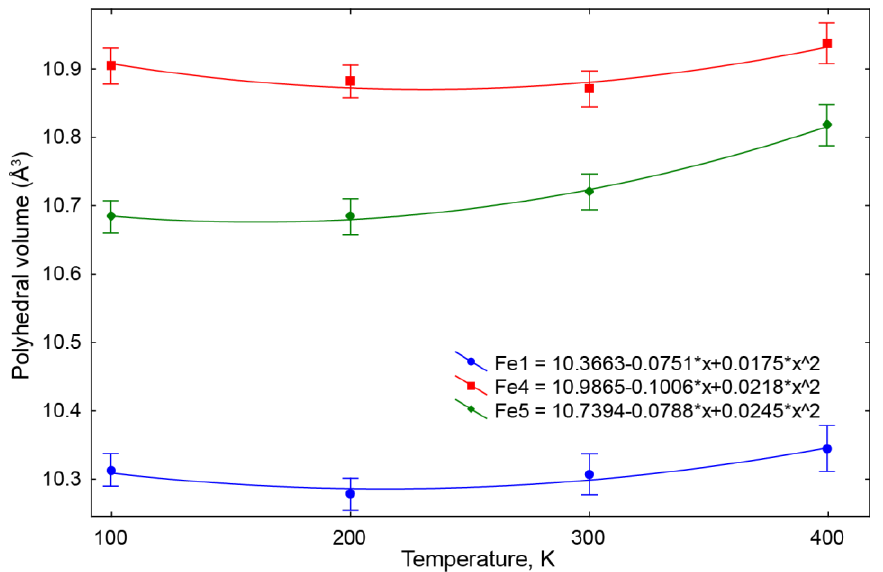
Figure 5. Polyhedral volumes of Fe1, Fe4, and Fe5 octahedra in the crystal structure of barioferrite at 100, 200, 300, and 400 K, respectively.